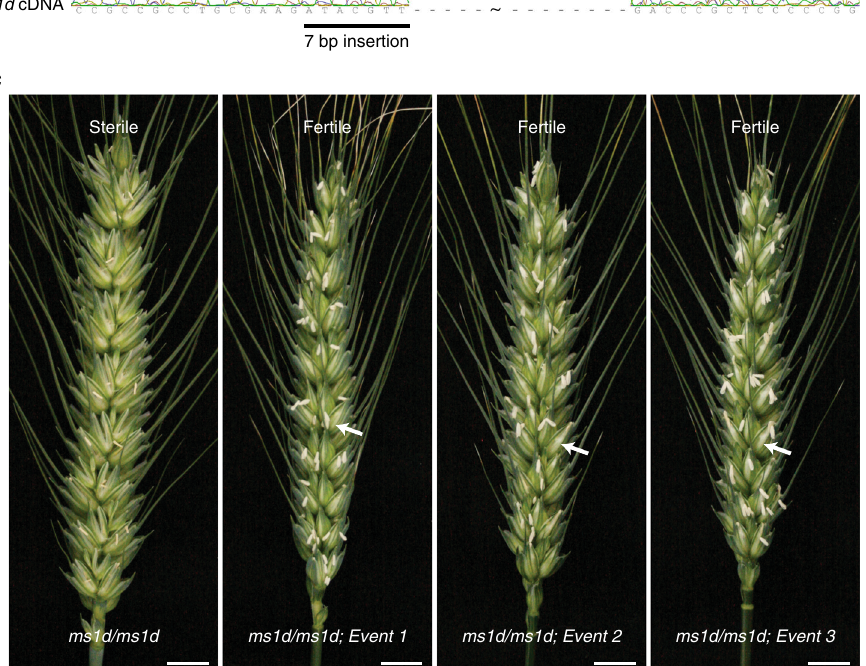
Fig. 3 Identity of male sterility inducing lesions within TaMs1 and in vivo complementation of ms1d / ms1d by TaMs1 . a Schematic representation of the TaMs1 (the three exons are shown as black boxes) gene depicting the relative positions (indicated by solid lines with arrowheads) of EMS-derived lesions (chromatogram insets) for ms1d , ms1e , ms1f and ms1h . Polymorphisms cause either a frame shift ( ms1d , ms1e ) or an amino acid transition in a conserved residue of TaMs1 ( ms1f , ms1h ). b Sequence chromatogram comparison between both mutant ( ms1d ) and wild-type genomic cDNAs. Polymorphism G329A of ms1d induces the use of a cryptic splice site (highlighted by a 7 bp insertion) within TaMs1 . c Stable complementation of the ms1d mutant by TaMs1 . Mature in fl orescences of male-sterile ms1d / ms1d , and three independent transformants (Events 1 – 3), each homozygous for ms1d , and showing a self-seed set (arrow). Scale bars: 1